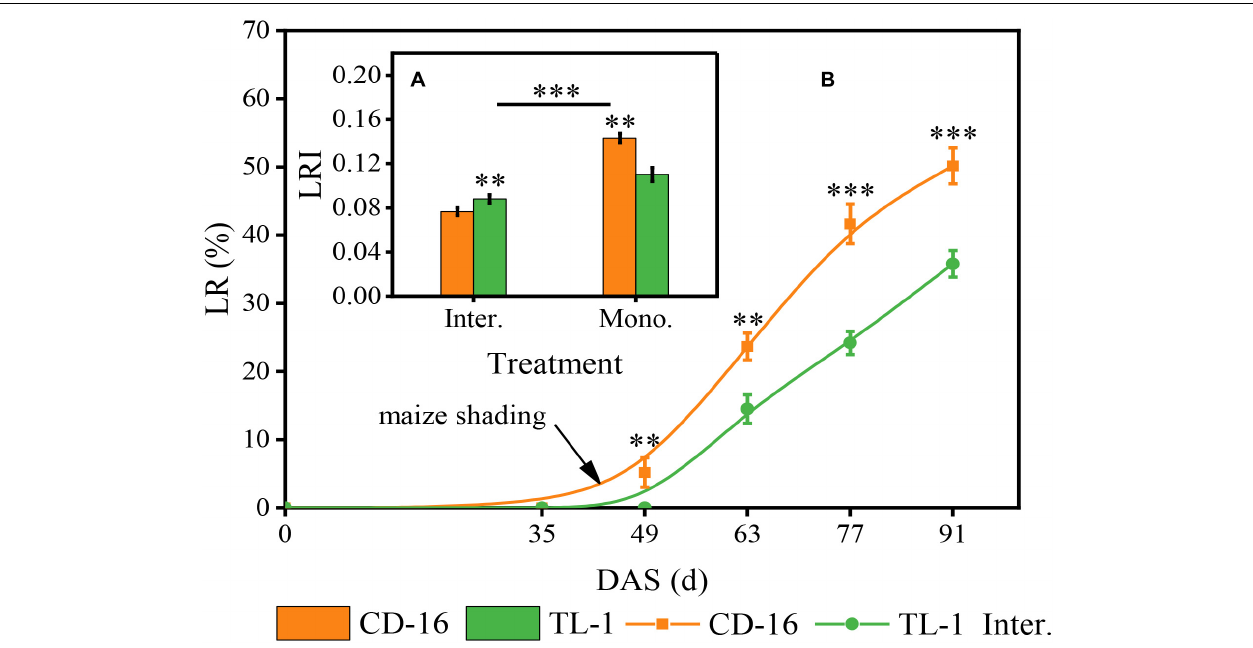
FIGURE 4 | Effects of different cultivars and planting patterns on LR (A) and LRI (B) . The ∗∗ and ∗∗∗ indicate significant differences between CD-16 and TL-1 at the levels of p < 0.01 and p < 0.001, respectively. The *** on the black short line indicates extremely significant differences between intercropping and monocropping at the levels of p < 0.001. Data are average of three replicates. Error bars represent standard errors. Mono. and Inter. are the abbreviation of monoculture and strip intercropping, respectively. DAS represents the number of days after sowing.